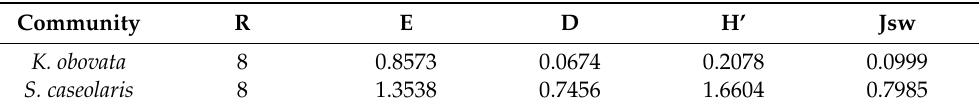
Table 4. Biodiversity indices of K. obovata and S. caseolaris communities on the west coast of Bao’an, Shenzhen. Community R